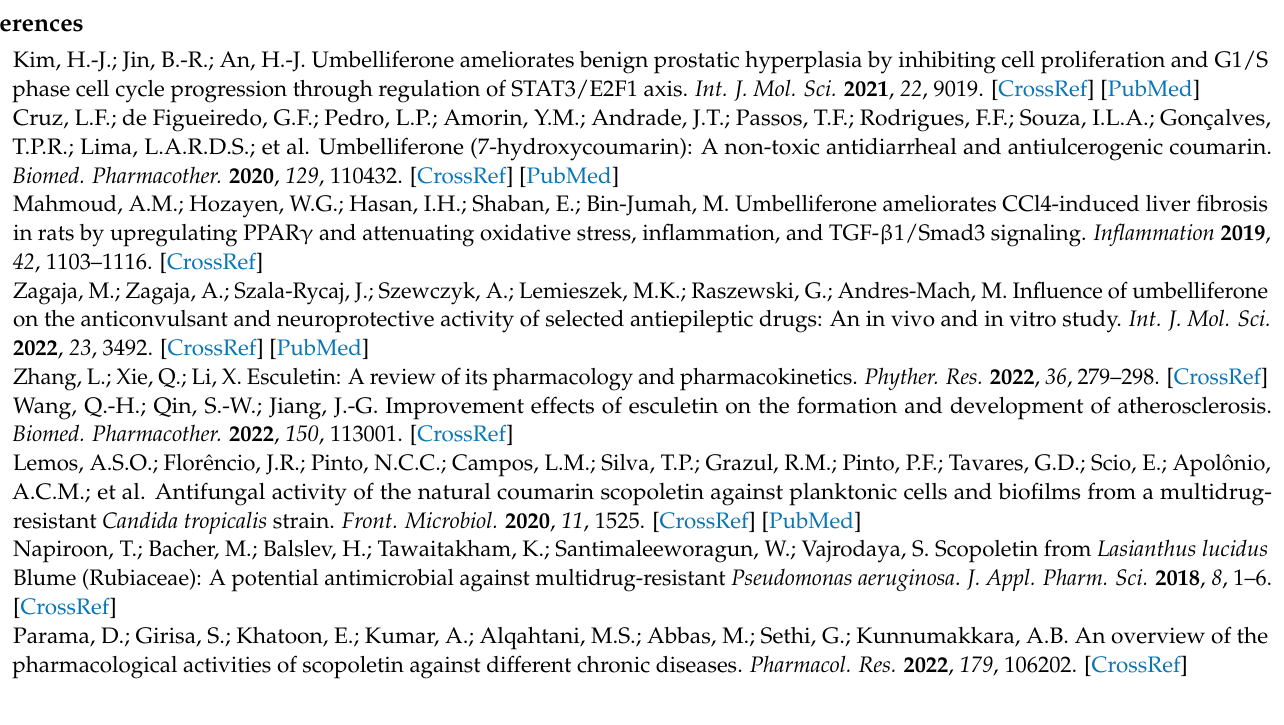
carica ; Figure S29: LocTree3 results for MS from Ficus carica ; Figure S30: BaCelLo results for MS from Ficus carica ; Figure S31: iPSORT results for MS from Ficus carica ; Figure S32: TargetP-2.0 results for MS from Ficus carica ; Figure S33: SignalP-5.0 results for MS from Ficus carica ; Figure S34: TMHMM-2.0 results for MS from Ficus